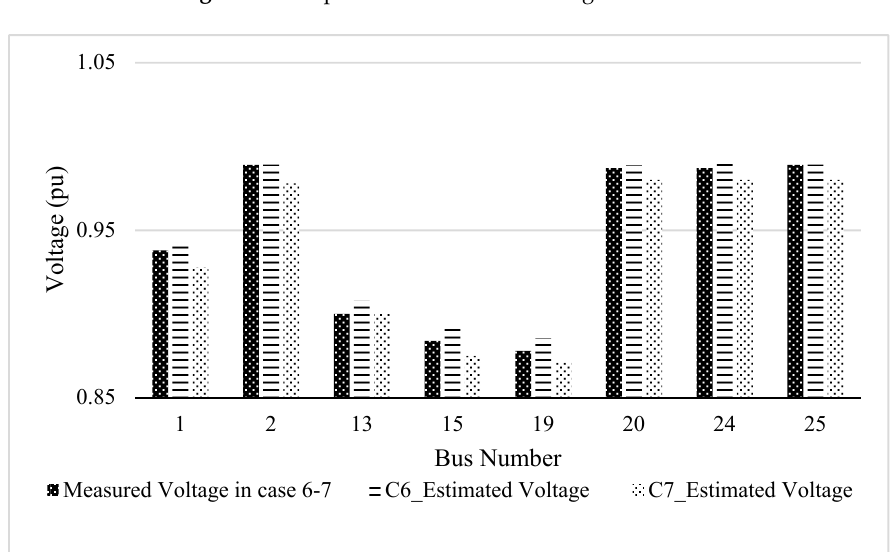
Figure 6. Comparison of estimated voltages for case 5.